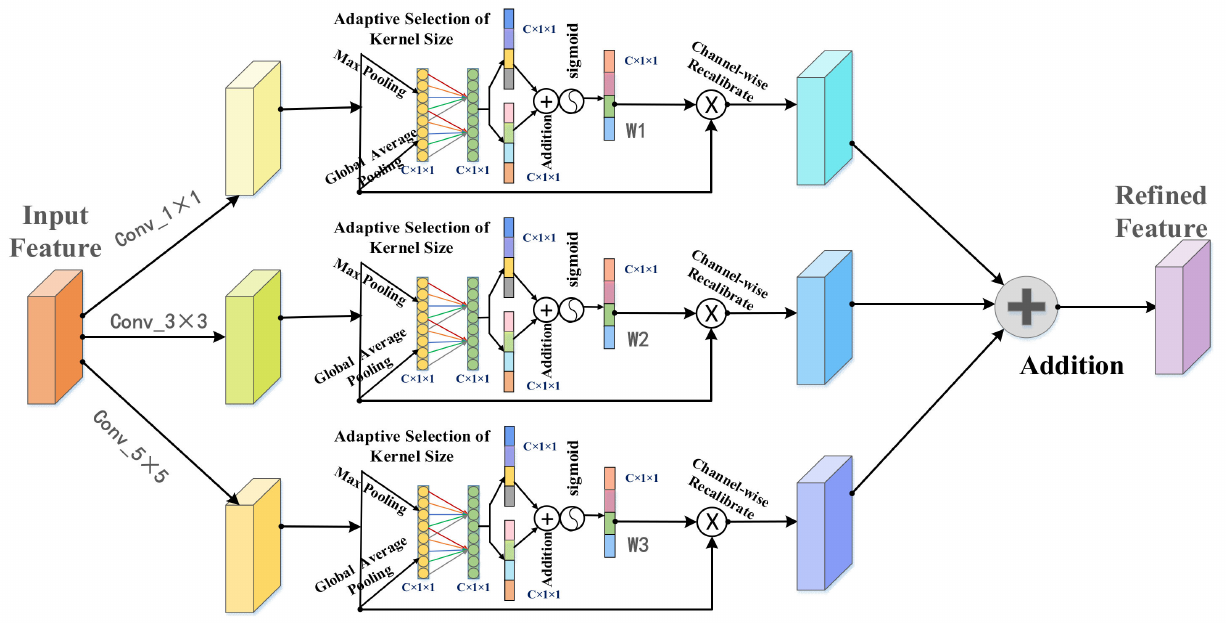
Figure 4. Mechanism of the multi-layered channel